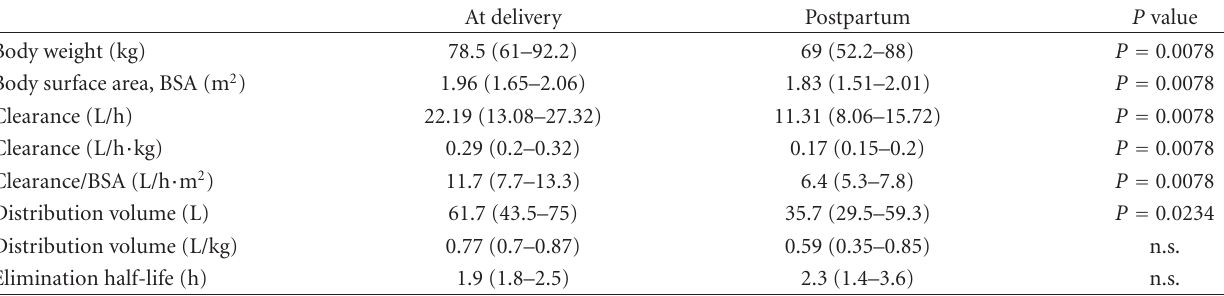
Table 1: Clinical characteristics and pharmacokinetic estimates for intravenous paracetamol (single dose, 2g) in 8 women as collected at delivery and in postpartum (10–15 weeks after delivery). Data provided by median and range.